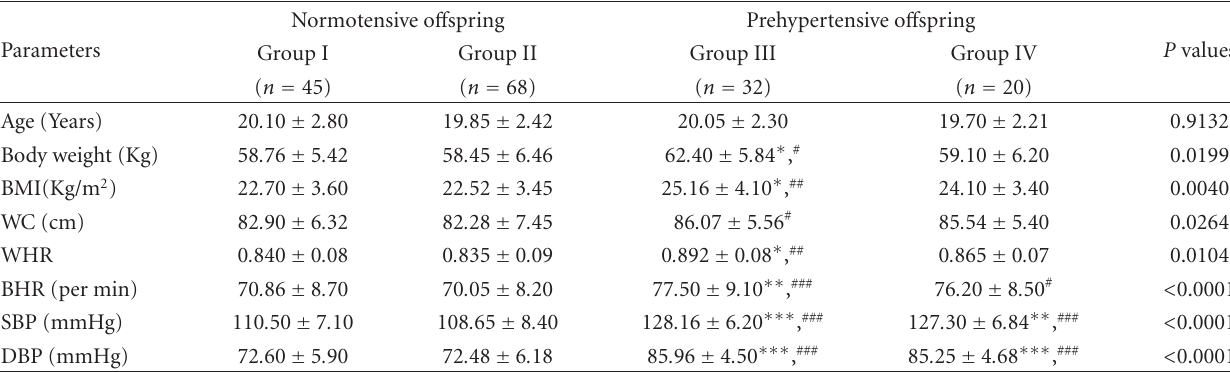
Table 1: Age, anthropometric, and basal cardiovascular parameters of subjects of various groups.